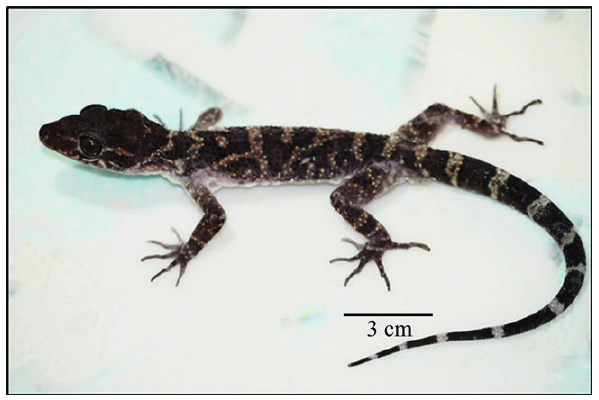
Figure 1. General characteristic shape of the Cyrtodactylus Intha- non , the most prominent feature in the top